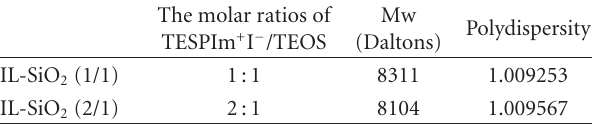
Table 1: The molecular weights of IL-SiO 2